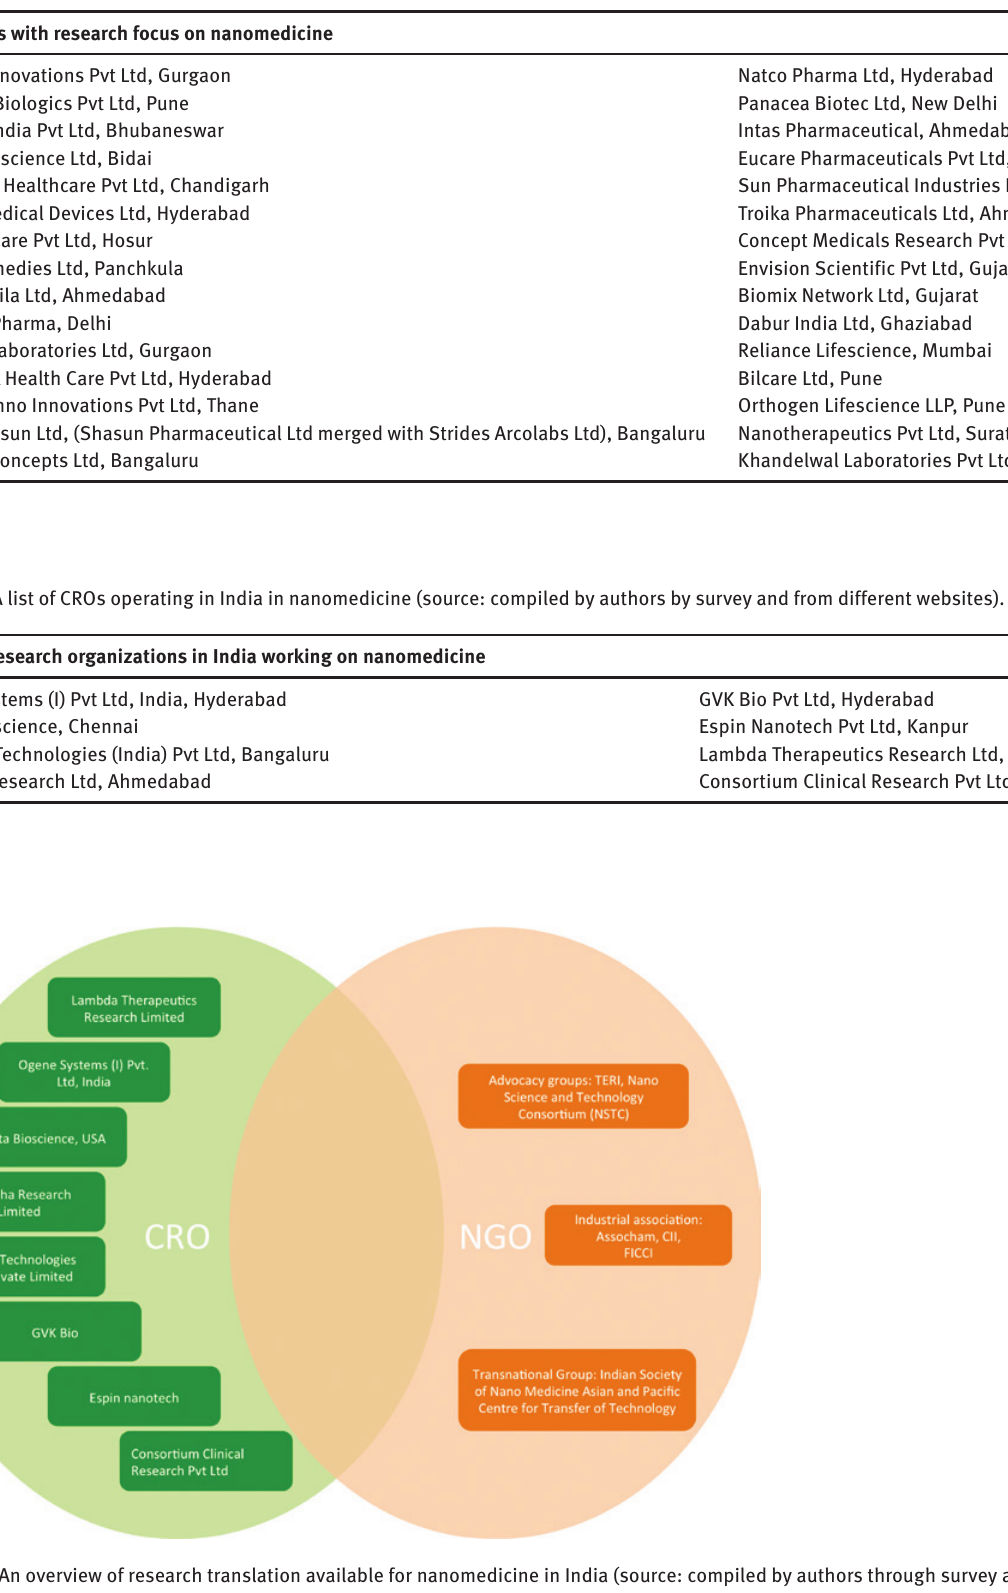
Figure 6: An overview of research translation available for nanomedicine in India (source: compiled by authors through survey and from various